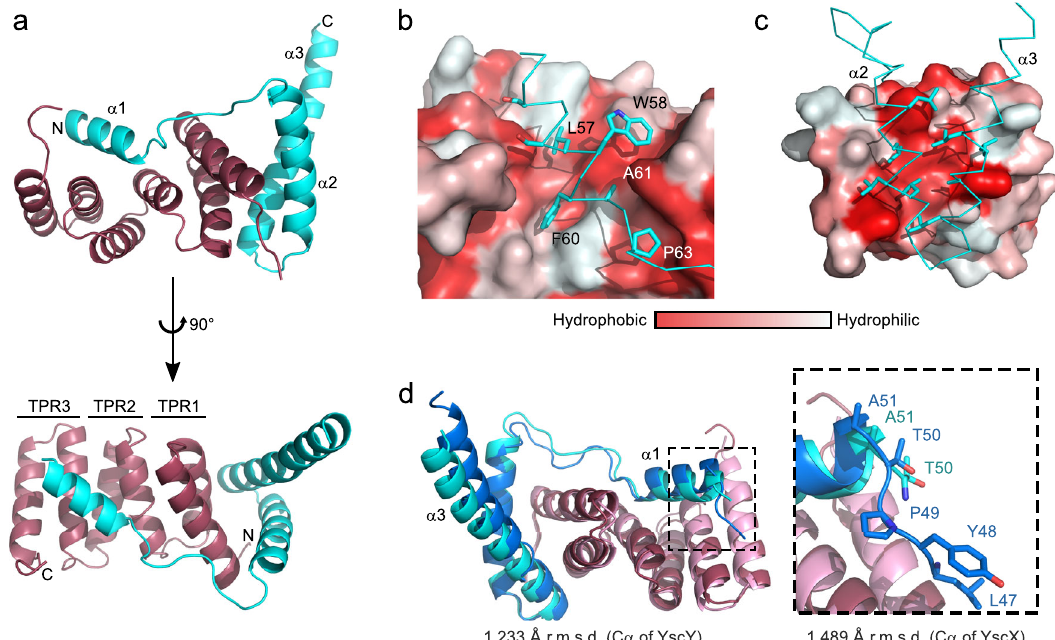
Fig. 1 Overall structure of the YscX:YscY heterodimer. a Cartoon representation of YscX (cyan) and YscY (red). YscX binds to YscY at two independent sites. b , c Surface hydrophobicity gradient of YscY shown from hydrophobic (red) to hydrophilic (white) using the normalized consensus hydrophobicity scale 65 . b YscX binds the groove of the TPR protein YscY via the hydrophobic side of a short amphipathic helix. c Two leucine-rich helices of YscX interact with the largely hydrophobic surface of the N-terminal TPR in YscY. d Superposition of YscX 50 :YscY (cyan and red) and YscX 32 :YscY (blue and pink) models. The alignment was calculated using the C α atoms of YscY. Zoom-in shows the YscX N-terminus before α 1 for both structures when aligned using the C α atoms of